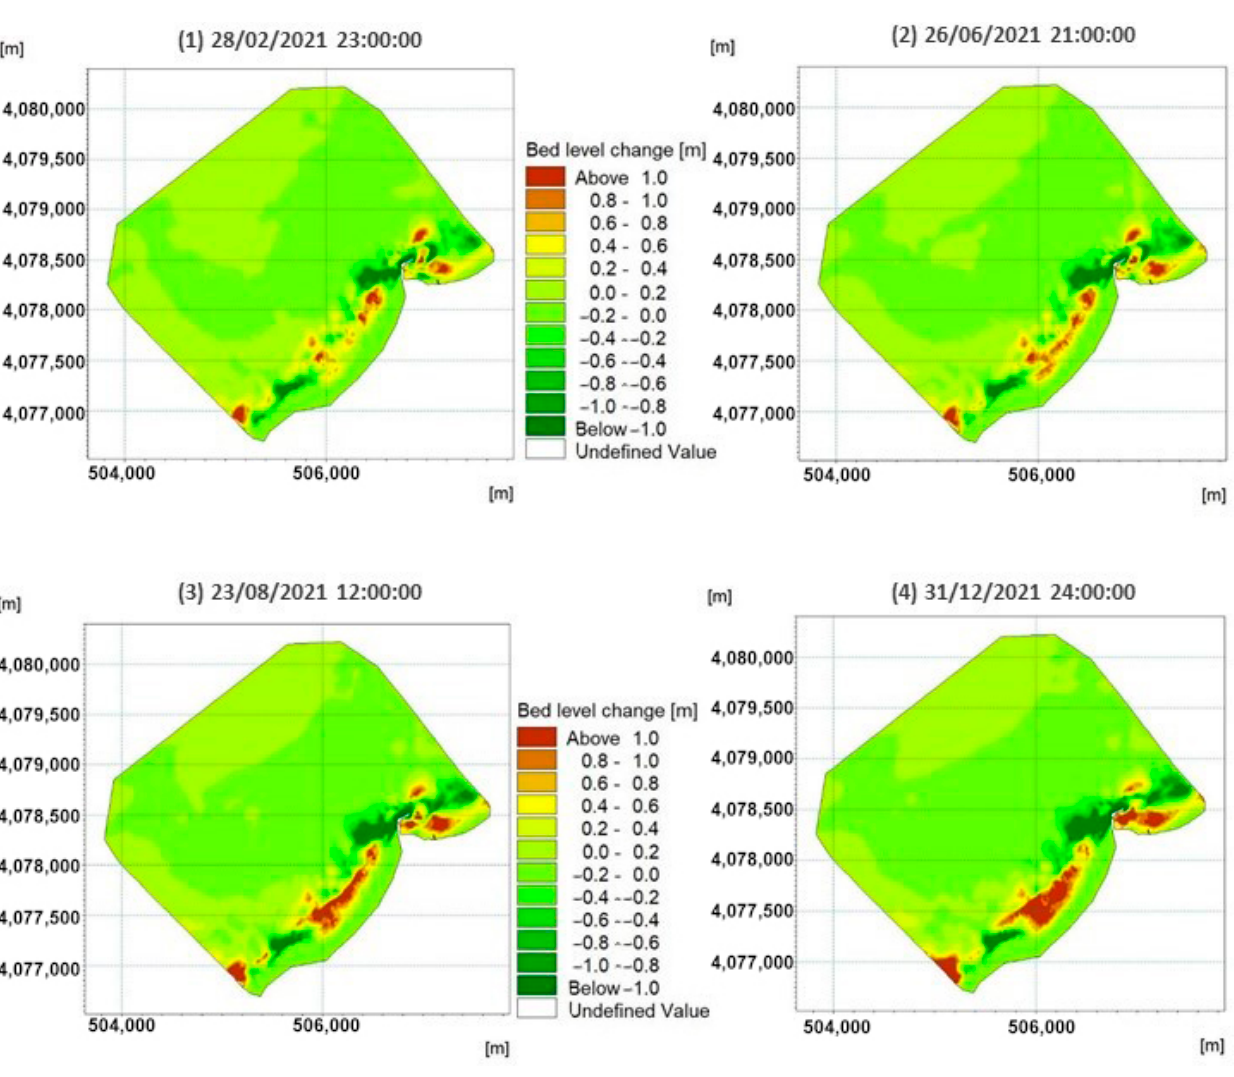
Figure 10. Bottom-level evolution maps at specific time steps of the year 2021 obtained by the wave chronology-based input reduction technique (5th simulation).